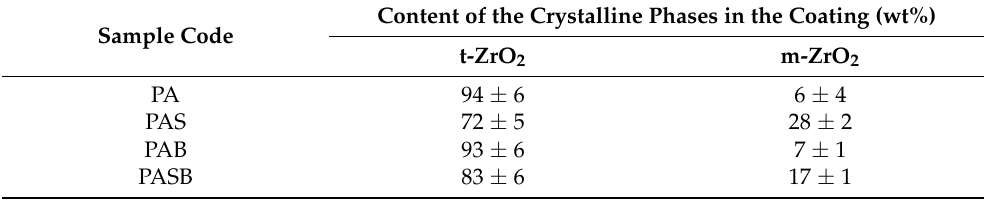
Table 5. Evaluation of the crystalline phases content (wt%) in the PEO coatings by the X-ray diffrac- tion analysis.